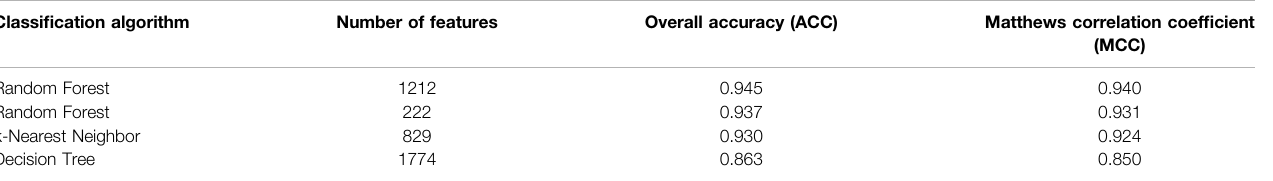
TABLE 2 | 10-fold cross-validation performance of some key classi fi ers based on different classi fi cation algorithms.